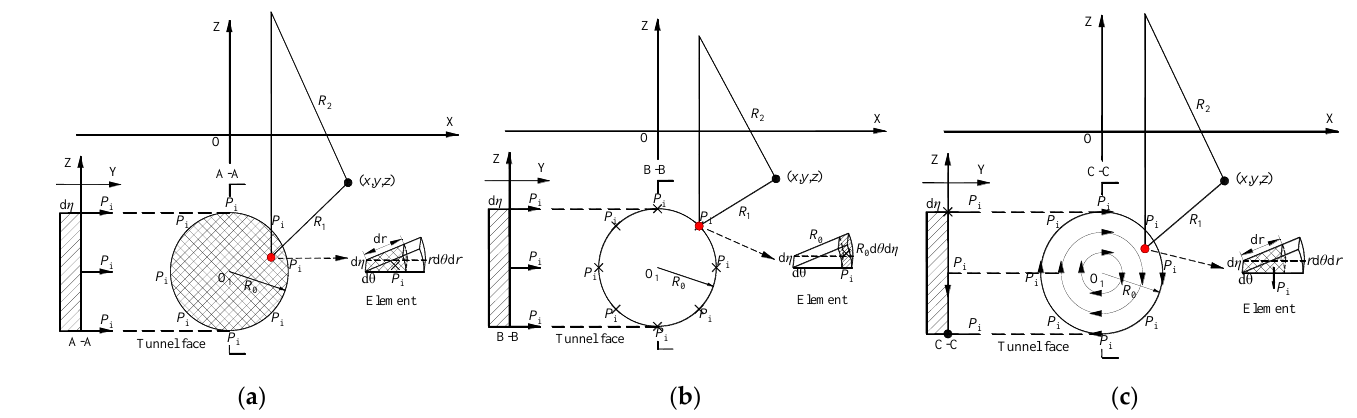
(12) Figure 3. A vertical load or horizontal load in the interior of an elastic half-space.